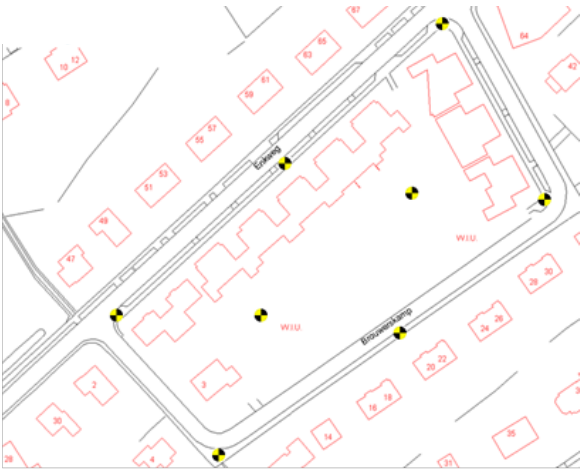
Figure-5: Overview of Nunspeet test area with locations of the ground control points